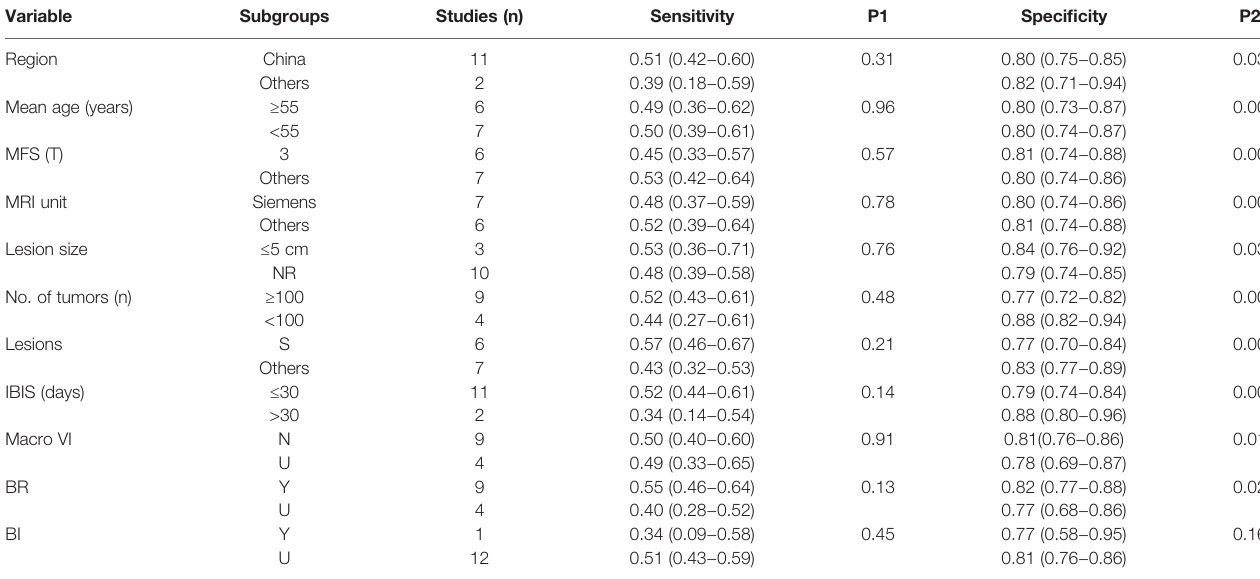
TABLE 3 | Subgroup analyses of peritumoral enhancement on arterial